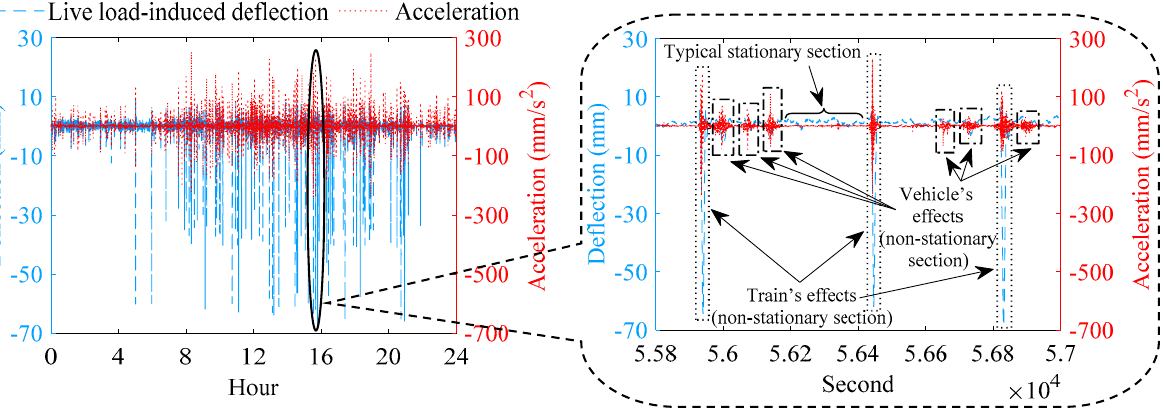
Figure 4. Live load-induced deflection and acceleration and their characteristics of time series signal.